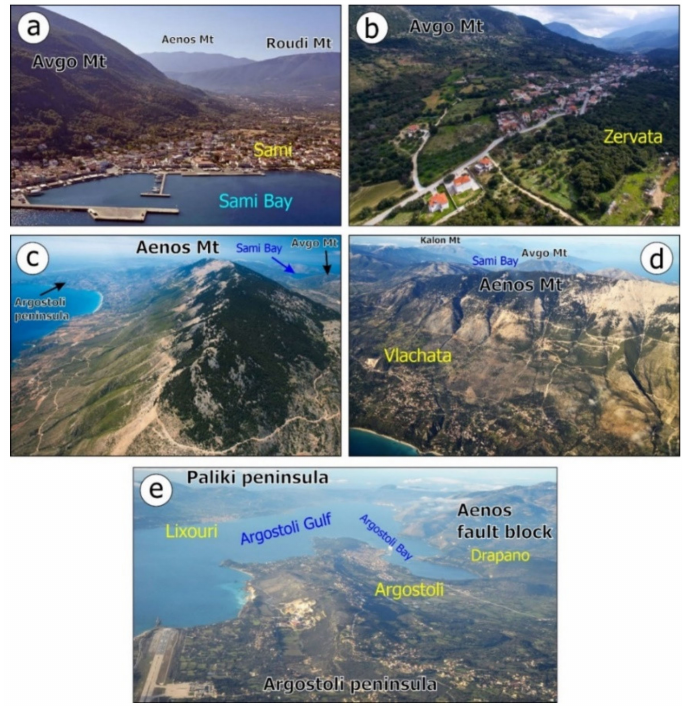
Figure 10. Slope failures were also triggered along the high and steep limestone slopes of several mountains in Cephalonia. Sami town ( a ) and Zervata village ( b ) and several villages founded along the front of Avgo Mt were heavily affected by rockfalls, as the residential areas were partially affected by the slope failures. Extensive rockfalls were also generated along the southern slopes of Aenos Mt ( c , d ) resulting in complete destruction of adjacent villages and impact on the local population. ( e ) Rockfalls were also induced in Lixouri located at the eastern part of Paliki peninsula and in Argostoli located at the northwestern end of the homonymous peninsula. Both affected areas are composed of post-alpine deposits.